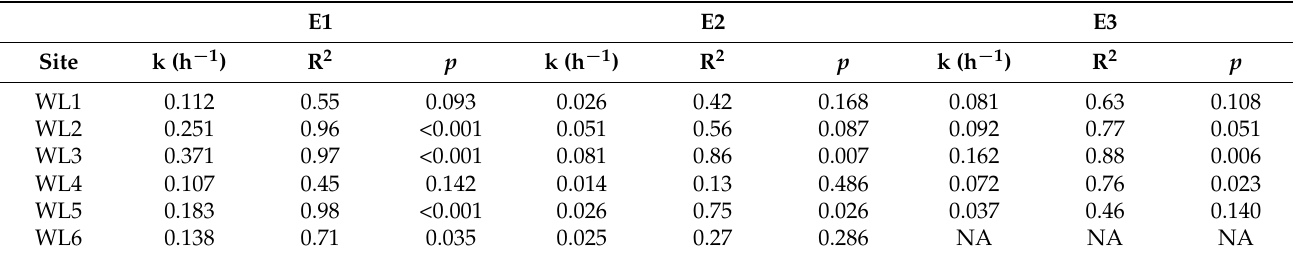
Table 6. The kinetic rates of degradation for free estrogens at sampling sites. E1 E2 E3